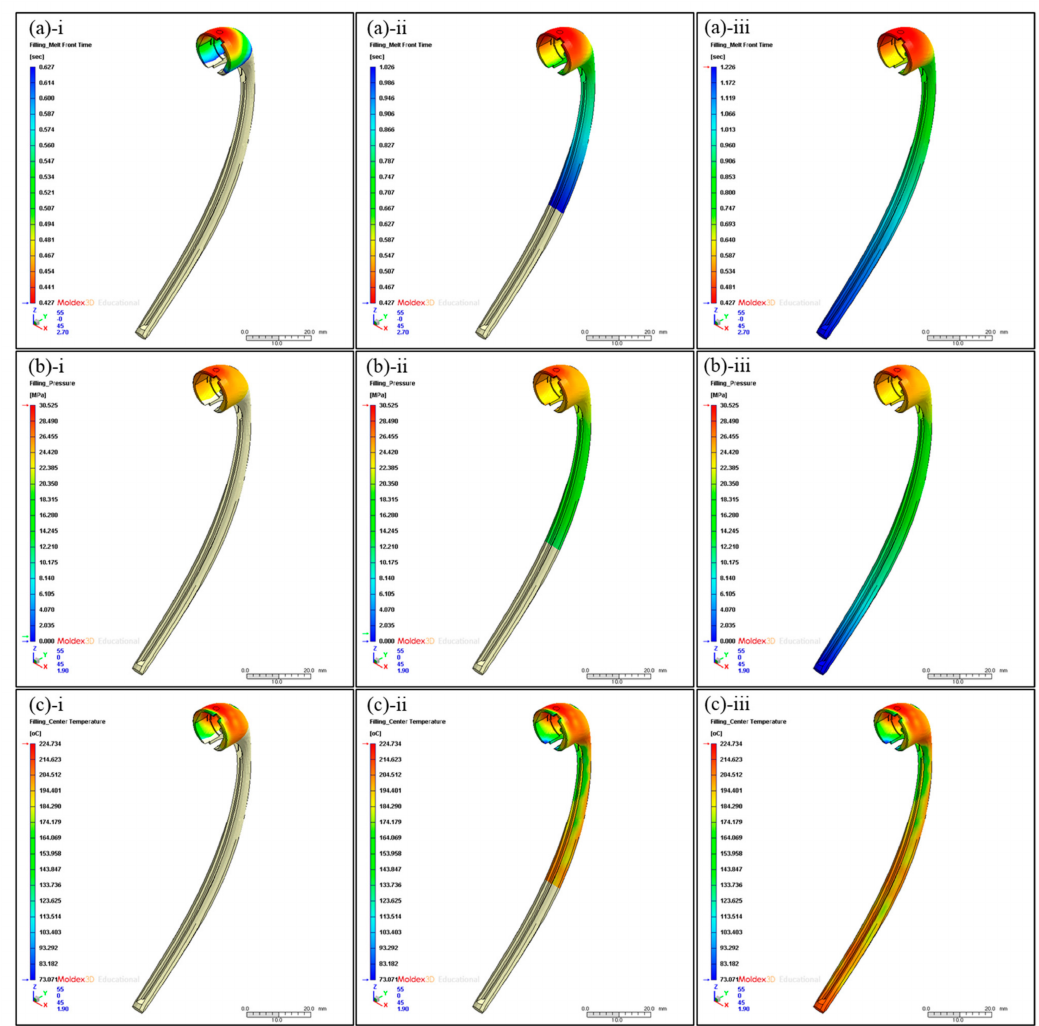
Figure 5. ( a ) Melt front of polymer in the mold cavity with respect to time: ( a-i ) 25%, ( a-ii ) 75%, and ( a-iii ) 100% filling. ( b ) Pressure distribution in the mold cavity with respect to time: ( b-i ) 25%, ( b-ii ) 75%, and ( b-iii ) 100% filling. ( c ) Center temperature distribution in the mold cavity with respect to time: ( c-i ) 25%, ( c-ii ) 75%, and ( c-iii ) 100%